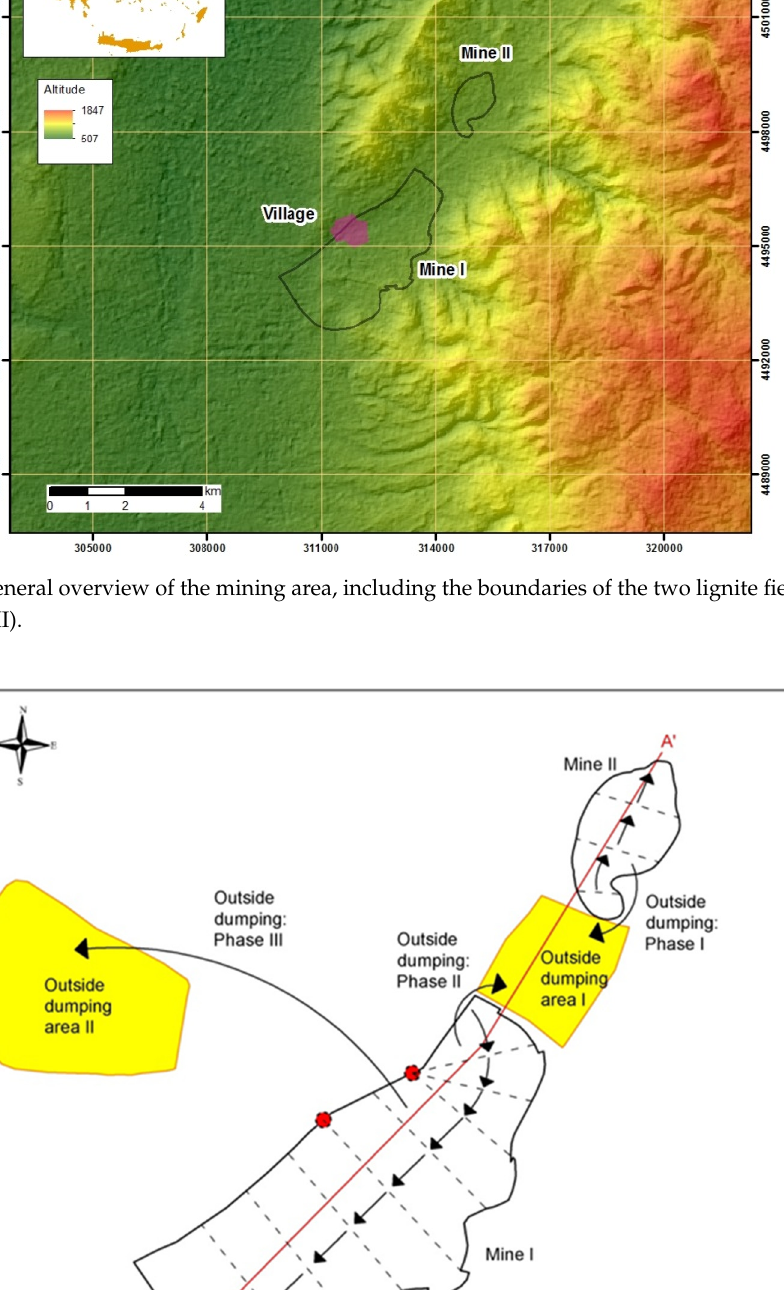
Figure 4. Sequence of mine development in the cross section A ‐ A’ of Figure 2. The main mining equipment consists of bucket wheel excavators, conveyors and spreaders and the decision making regards the optimal restoration of the mine after 25 years of operation, while its remaining life is 10 years. At this stage, the waste material of the excavation activities is transported